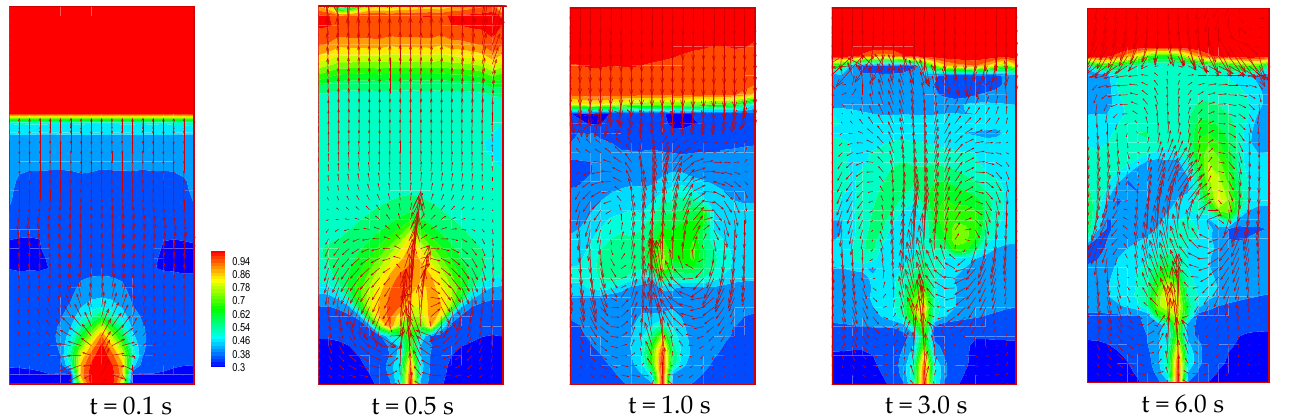
Figure 4. Instantaneous porosities and velocities of EG particles in a bubbling fluidized bed, ρ p = 800 kg/m 3 .